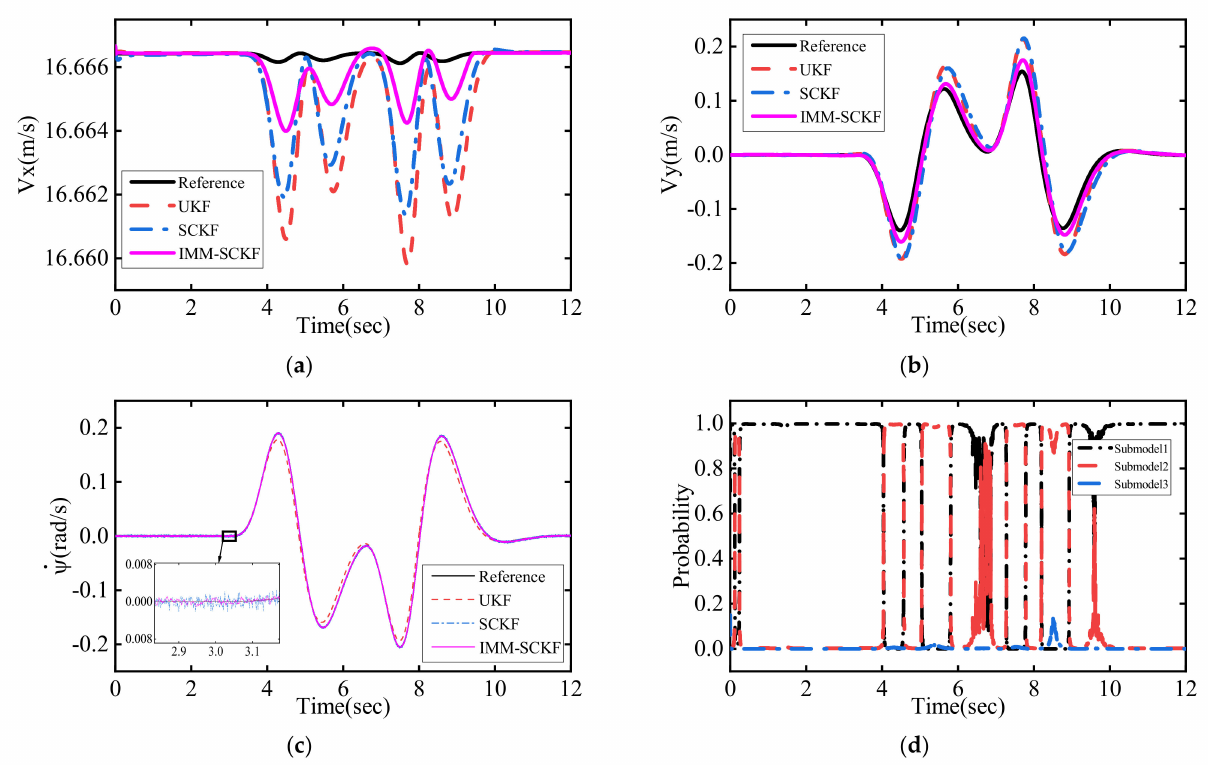
Figure 5. Simulation results of vehicle state under double-lane change condition: ( a ) longitudinal velocity; ( b ) lateral velocity; ( c ) yaw rate; ( d ) probability of each IMM’s